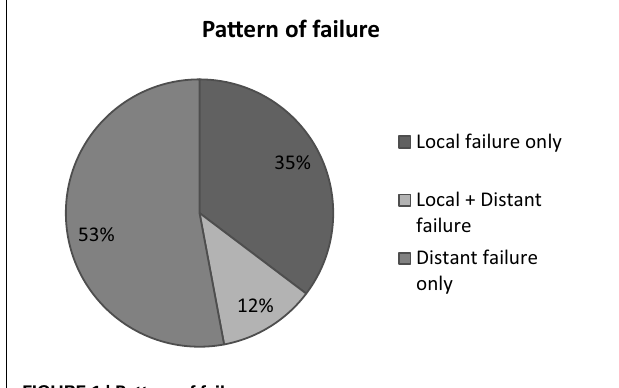
FIGURE 1 | Pattern of failure .